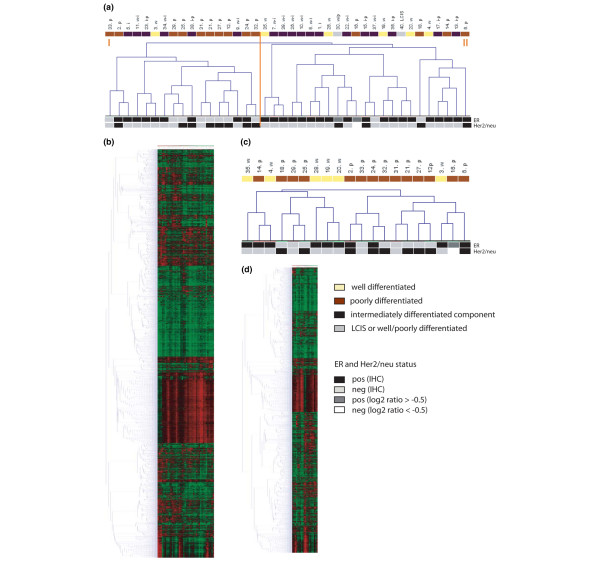
Unsupervised hierarchical clustering of the in situ samples. (a) Dendrogram of all 40 in situ samples. (b) Scaled-down representation of the entire cluster of (a) (5,788 genes). (c) Dendrogram of only the well- (n = 6) and poorly (n = 14) differentiated ductal carcinoma in situ (DCIS) cases. (d) Entire cluster of (c) (4,493 genes). Yellow indicates well-differentiated DCIS, brown indicates poorly differentiated DCIS, black indicates DCIS samples with an intermediately differentiated component, and gray indicates special cases. i, intermediately differentiated; IHC, immunohistochemistry; i-p, intermediately-poorly differentiated; LCIS, lobular carcinoma in situ; p, poorly differentiated; w, well differentiated; w-i, well-intermediately differentiated.